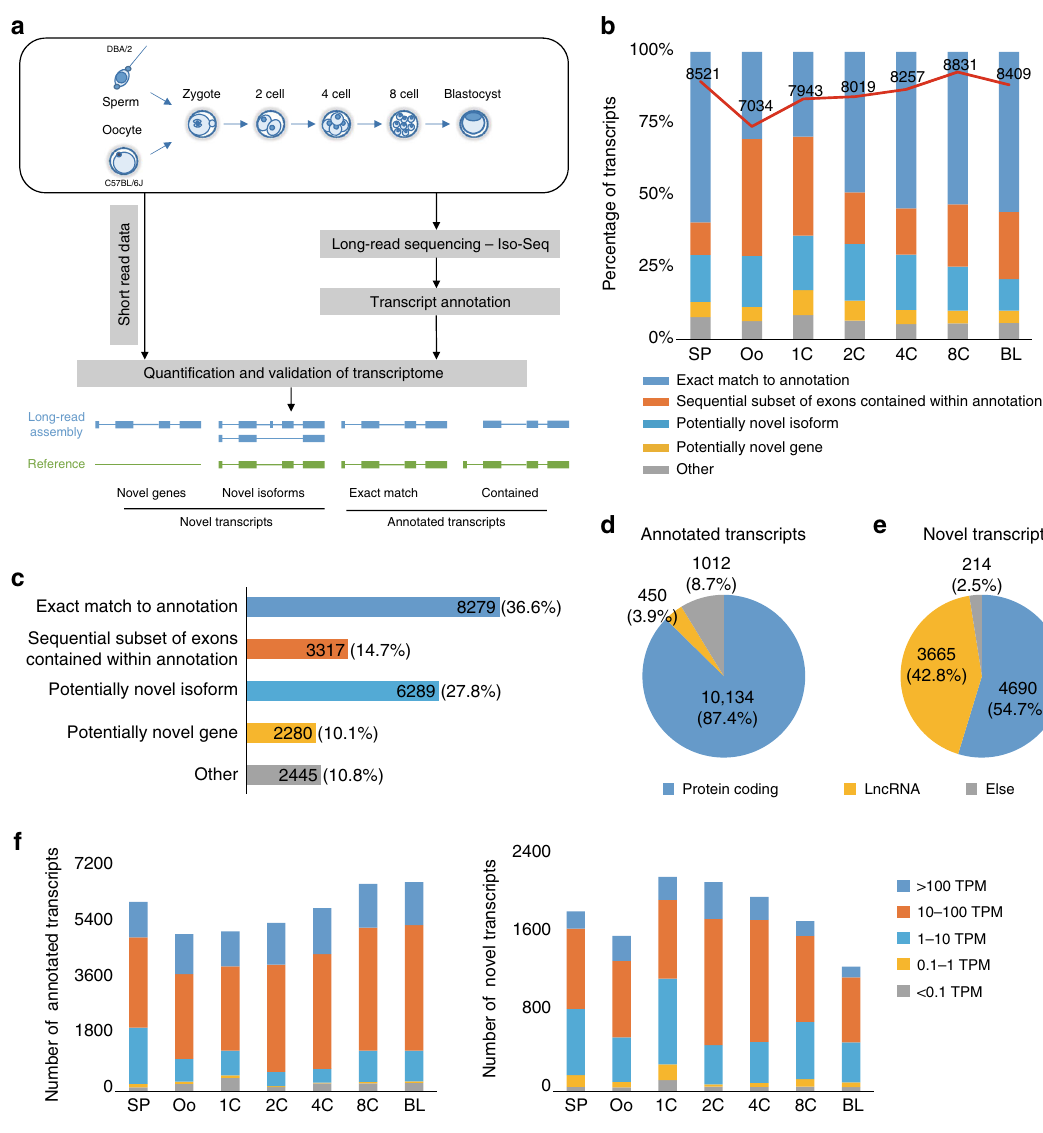
Fig. 1 Identi fi cation of novel transcripts using PacBio SMRT sequencing in seven stages of preimplantation mouse embryos. a Work fl ow for transcriptome reconstruction based on PacBio SMRT sequencing data. The Iso-seq3 pipeline was used to assemble transcripts from long-read data, and these transcripts were then mapped to the reference genome with GMAP and compared with the GENCODE (vM20) annotation using Cuffcompare. Zygotes and in vitro cultured embryos from female C57BL/6J and male DBA/2 inbred mice were collected. For a batch of samples, 150 oocytes (Oo), 150 1-cell embryos (1C), 100 2-cell embryos (2C), 50 4-cell embryos (4C), 25 8-cell embryos (8C), 20 blastocysts (BL, 32-64C), and bulk sperms, were collected for experiments. Long-read transcripts were also validated and compared to short-read data. b Annotation of identi fi ed long-read transcripts